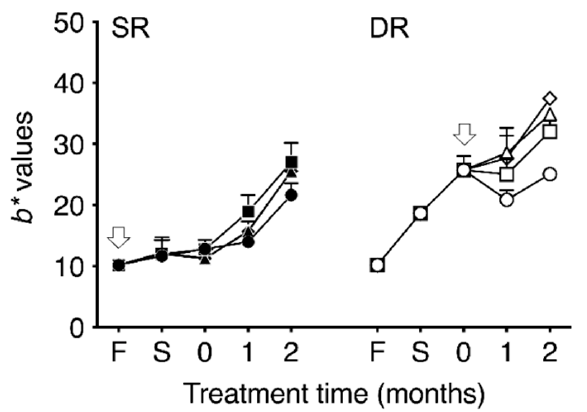
Figure 4. Time-dependent changes in b * values during the dehydration and salting process with different concentrations of McIlvaine buffering agent. SR indicates dehydration by salting (shio-oshi takuan-zuke); DR indicates dehydration by sun-drying (hoshi takuan-zuke). The arrows denote the time point of salt addition. F denotes the pH obtained from fresh daikon. S denotes the pH obtained from the dehydrated daikon after one week of salting. “0” denotes the start of the salt-aging process. Symbols refer to different concentrations of McIlvaine bu ff ering agent (mmol/kg): ● , SR0; ■ , SR10; ▲ , SR20; ◆ , SR40; ○ , DR0; □ , DR10; △ , DR20; ◇ , DR40. Values are mean ± standard deviation (SD) ( n = 3).